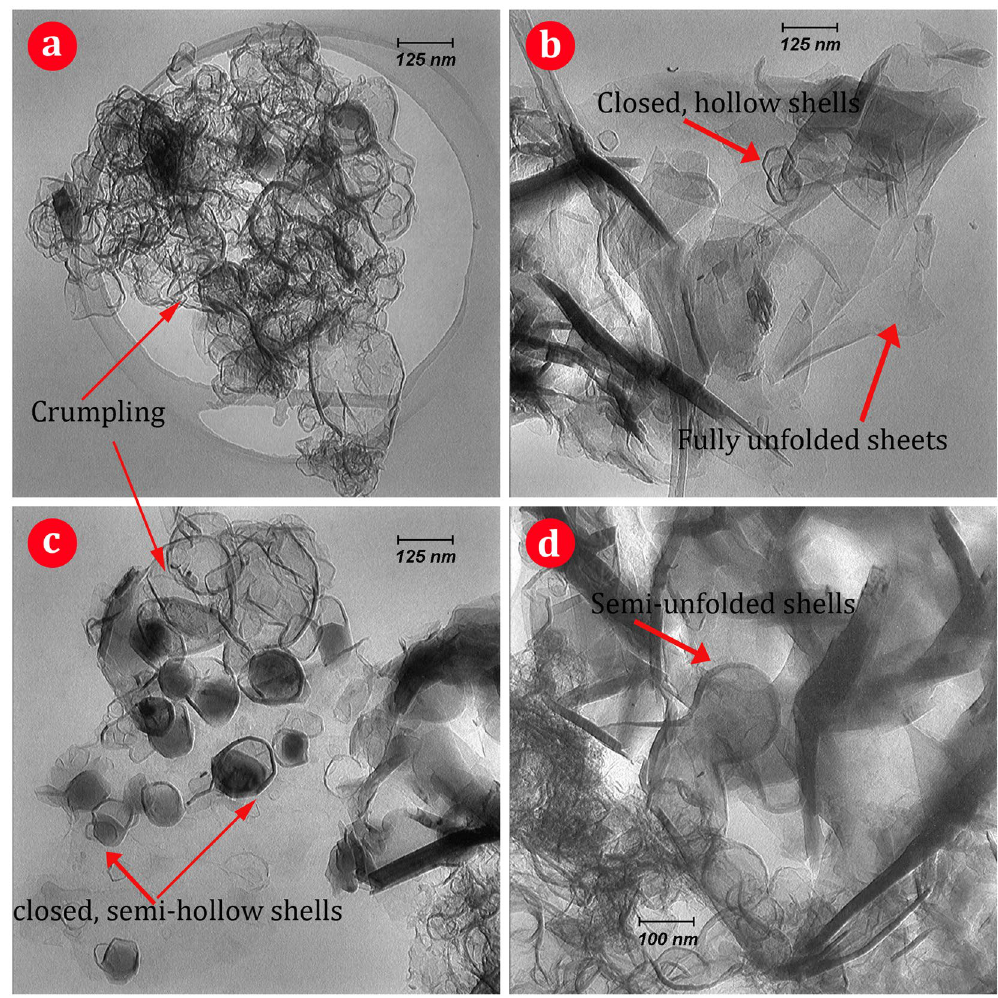
Figure 6. TEM images of the synthesized BCN